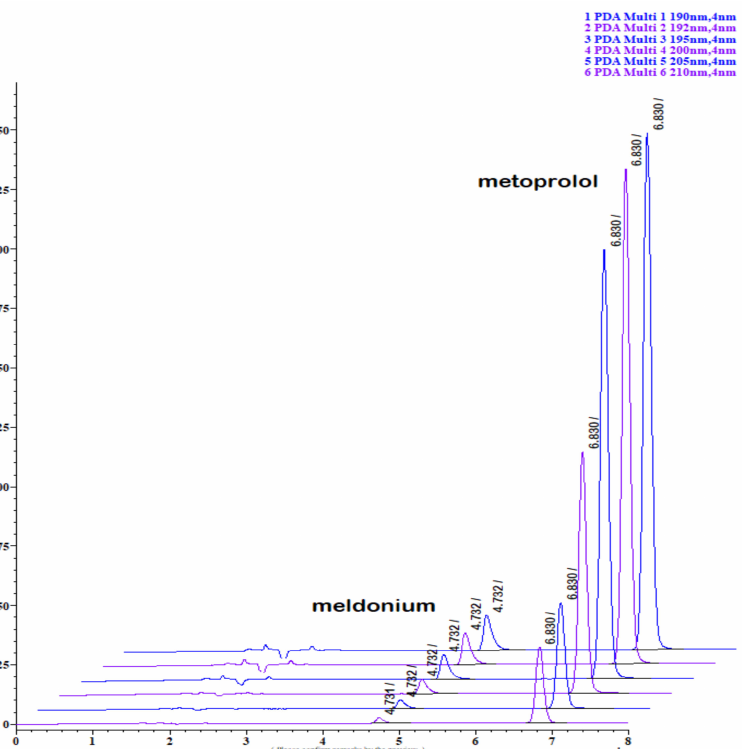
Figure 18. Chromatogram of sample 2.5 mg/mL meldonium and 0.5 mg/mL metoprolol with Waters Spherisorb CNRP-250 × 4.6 mm eluted 0.15% NH 4 H 2 PO 4 + 70% ACN full view.